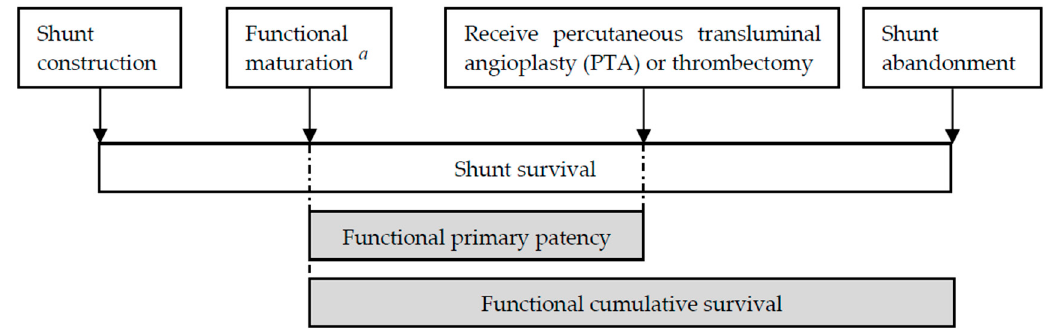
Figure 2. Definitions of shunt survival. a Functional maturation: shunt is cannulated for hemodialysis successfully